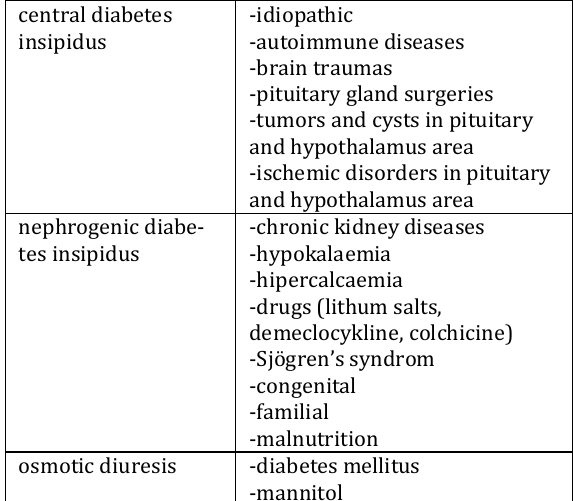
Tab.1 Causes of the secondary